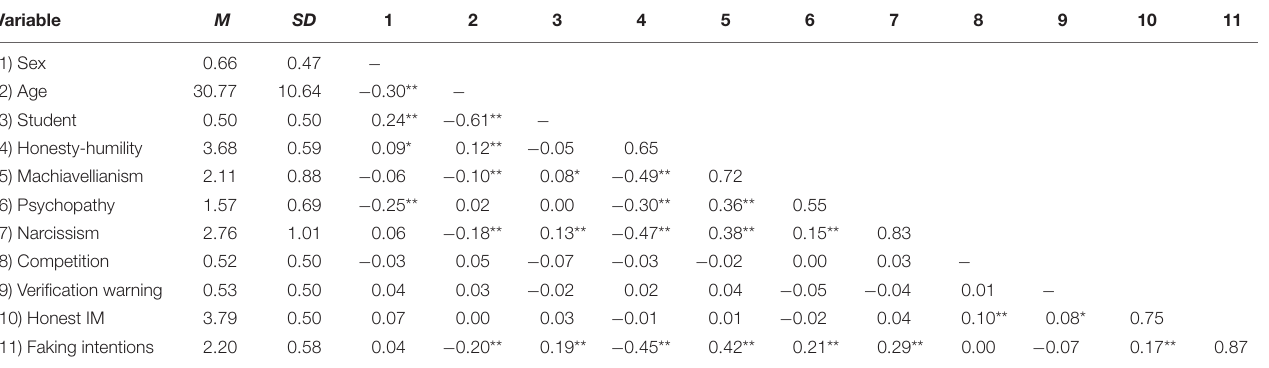
TABLE 5 | Correlations, means, and standard deviations among all study variables in Study 3.